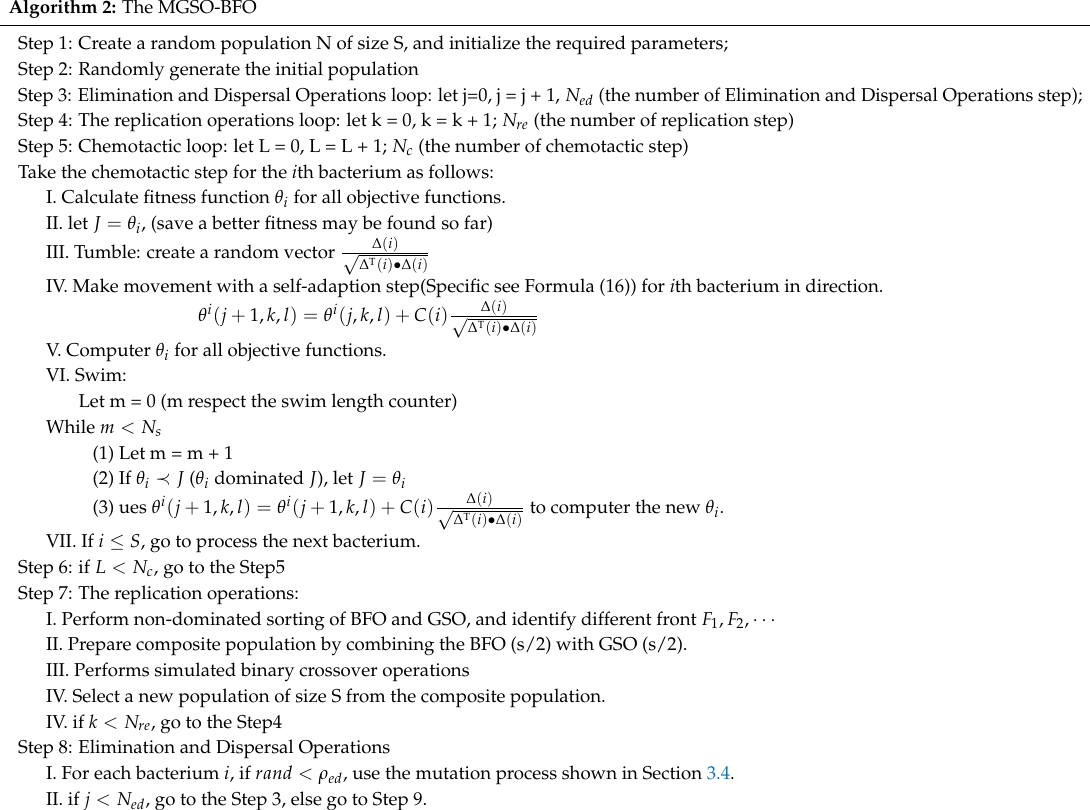
Algorithm 2: The